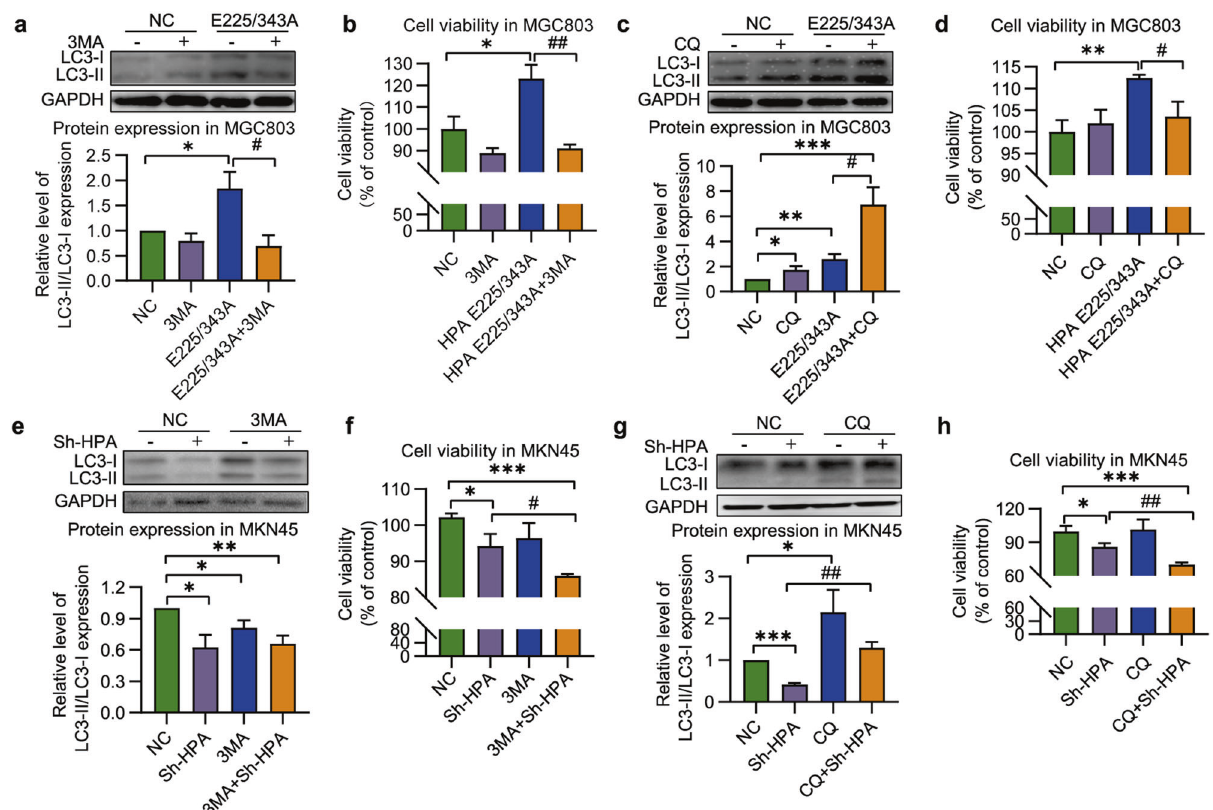
Fig. 3 LC3 protein abundance and cell viability induced by nonenzymatic HPA and reversion by autophagy inhibitor. a Western blot analysis of LC3-II and ( b ) Viability of MGC803 cells after transfection with nonenzymatic HPA with or without 3MA. c Representative image and quanti fi cation of LC3-II protein level, and ( d ) proliferation of MGC803 cells overexpressing HPA mutant in the absence or presence of CQ. e Level of LC3-II and ( f ) viability of HPA-knockdown MKN45 cells with or without 3MA treatment. LC3-II protein abundance ( g ) and viability ( h ) of MKN45 cells after HPA-knockdown in the presence and absence of CQ. * P < 0.05, ** P < 0.01, *** P < 0.001 versus the NC group, # P < 0.05, ## P < 0.01 versus the HPA E225/343A double mutant group or Sh-HPA